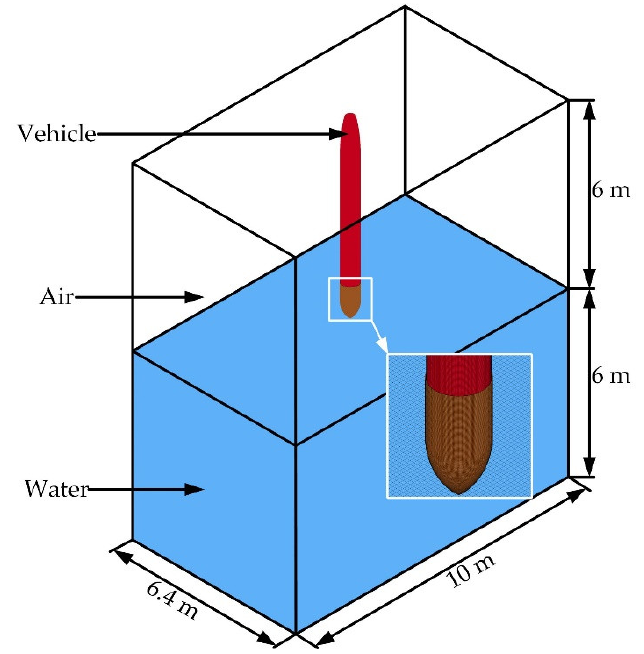
Figure 10. Schematic diagram of the calculation domain. Table 9. Situations of simulation.